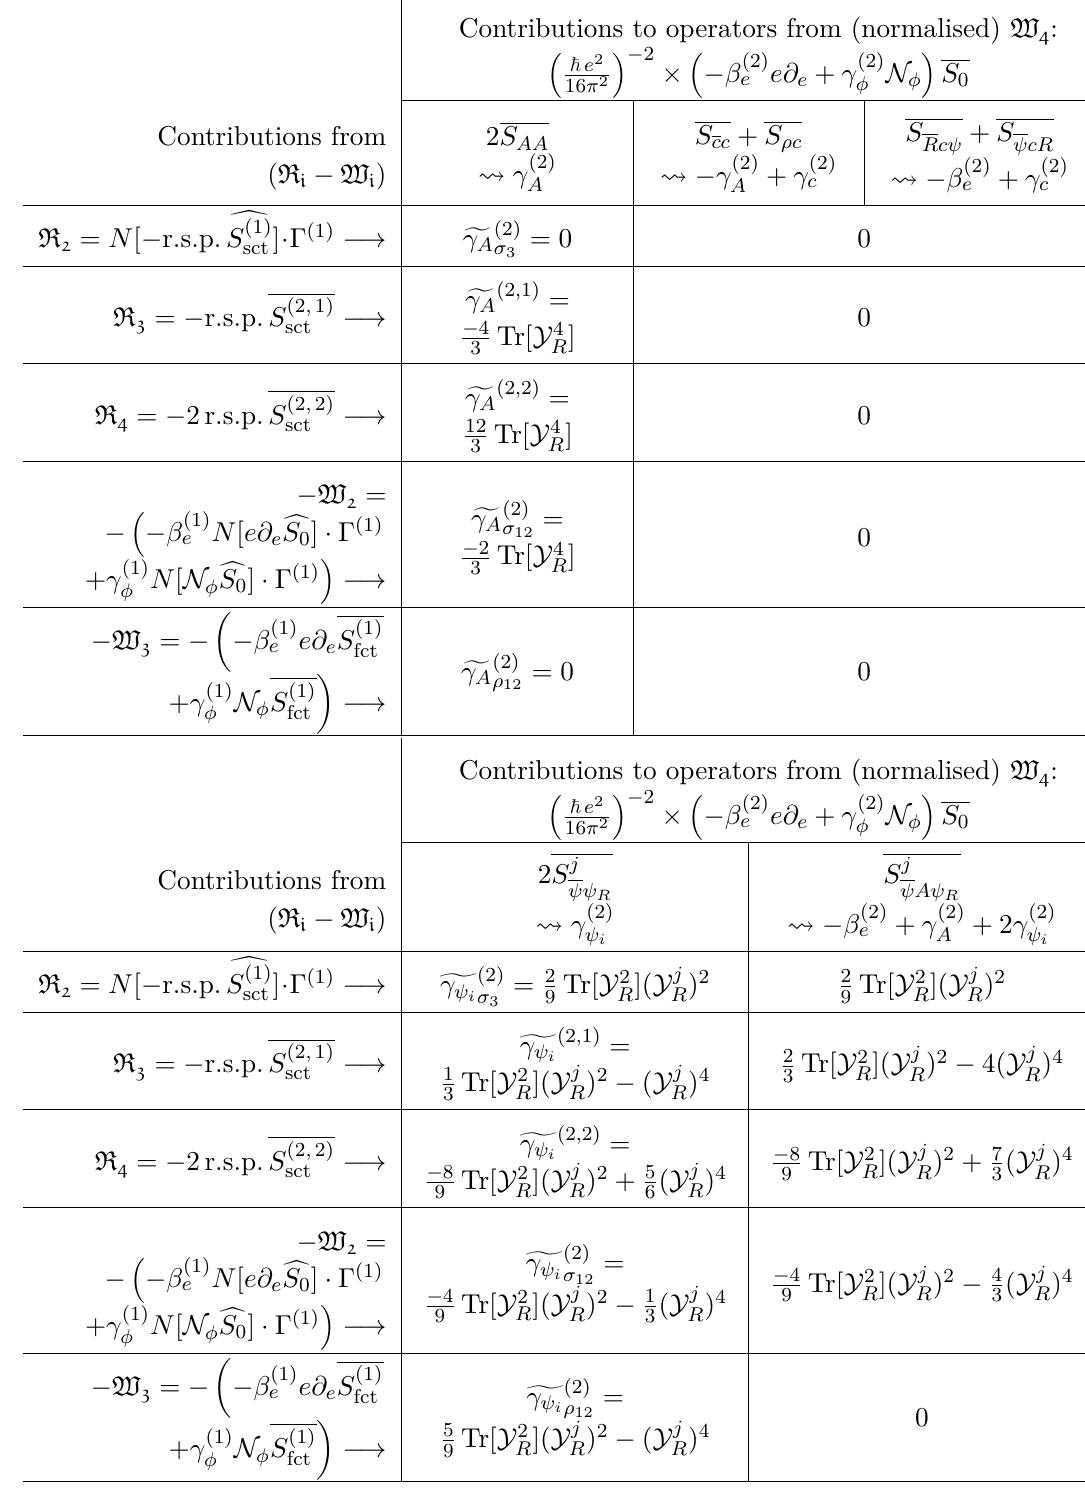
Table 1 . Contributions to the gauge (upper table) and fermionic (lower table) operators of